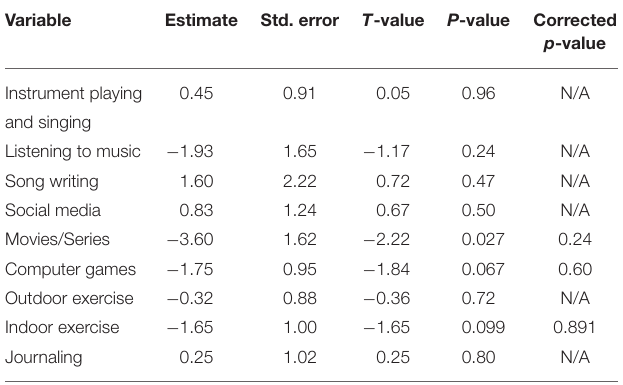
TABLE 2 | Effects of participating alone or with others on state anxiety scores (with alone as the reference point; corrected p –values use Bonferroni correction for the 9 models